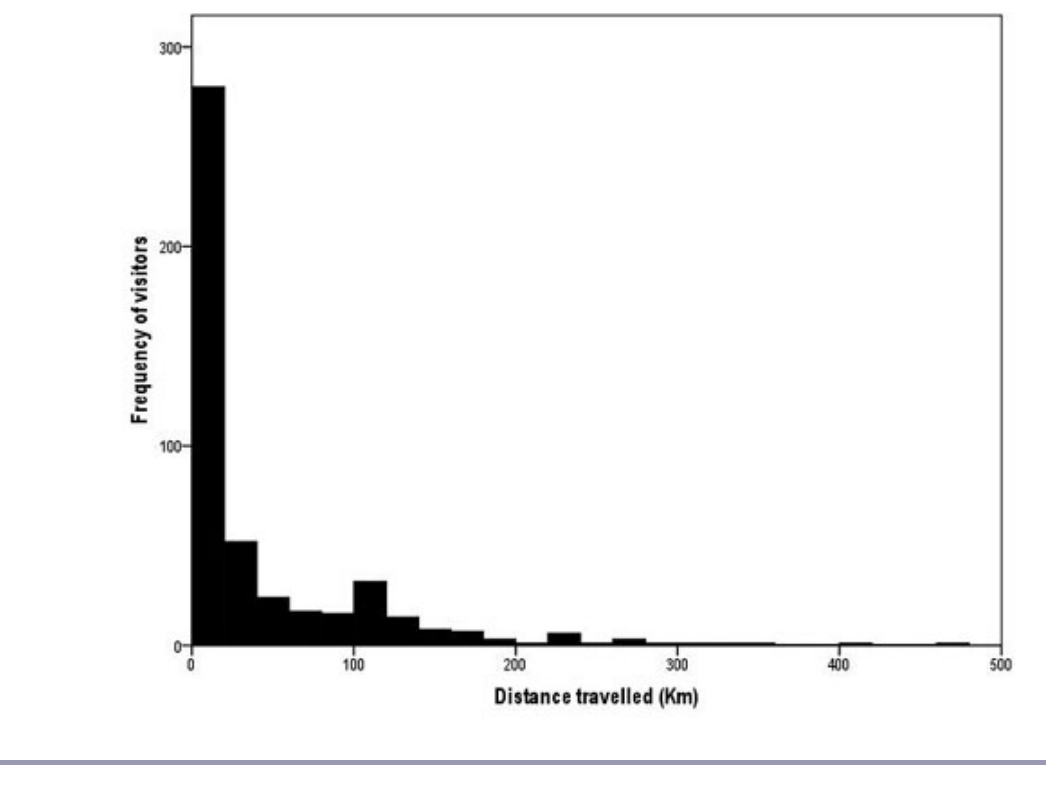
Fig. 1 . Histogram showing frequency of individual visits vs. distance traveled per visit for all 13